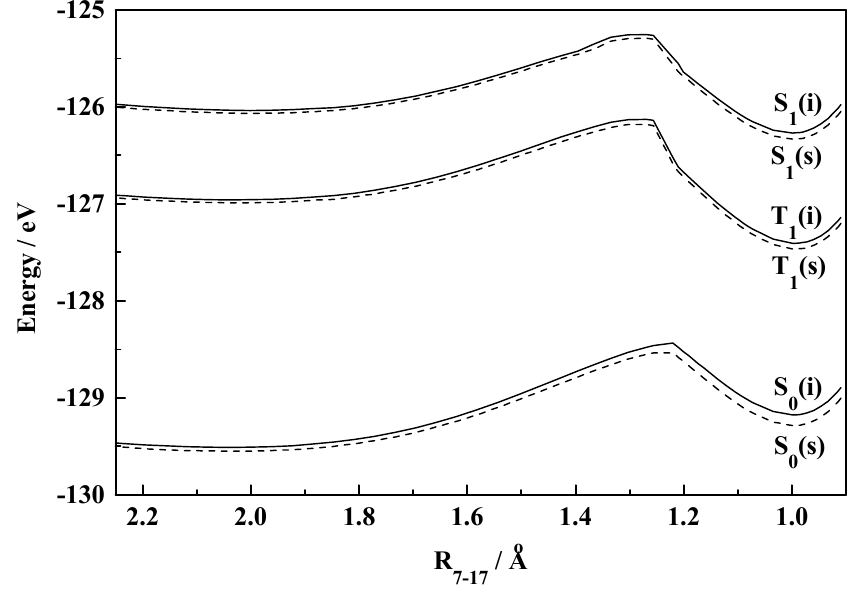
Figure 8. Simulated PECs for IPT process of HBI in S